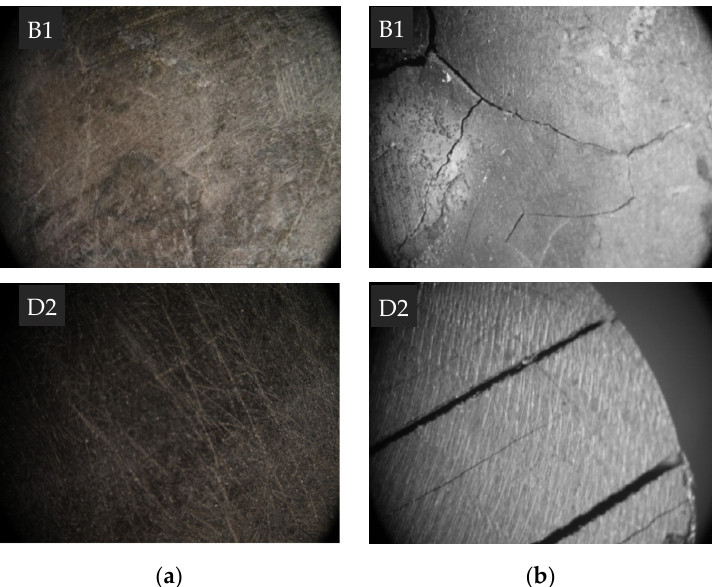
Figure 7. Photos of the microstructure of samples B1 and D2 ( a ) before the treatment and ( b ) after the microwave treatment (48× magnification).